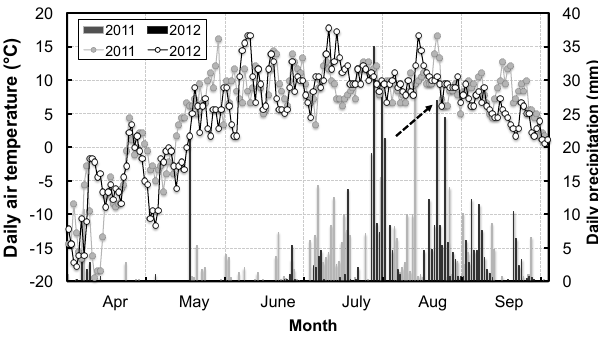
Figure 1. Average daily ambient temperature and precipitation in Council, Seward Peninsula, Alaska during April–October of 2011 and 2012 (Western Regional Climate Center). Dotted arrows denote that cumulative rainfall in 2012 exceeds that of 2011, beginning 20 August